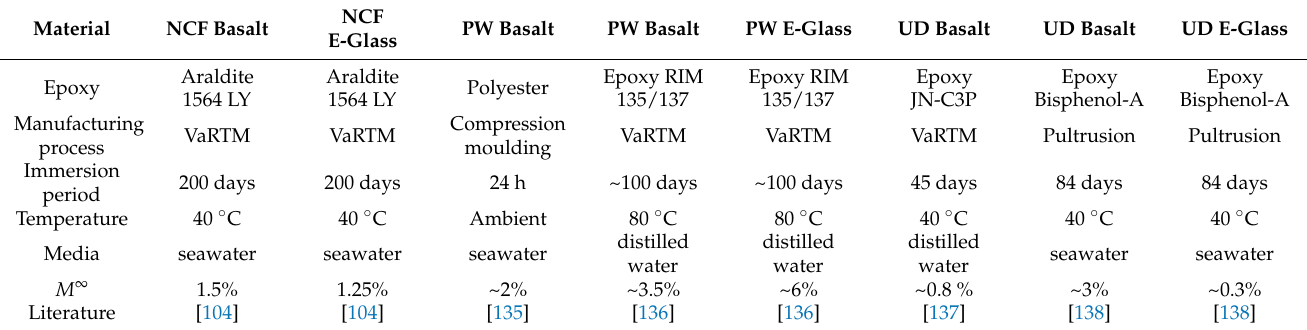
Table 5. An overview of the variation in moisture absorption capacity, M ∞ . data obtained from the lit- erature when different types of reinforcement, epoxy resin, manufacturing technology and condition- ing environment has been used (PW—Plain-woven, NCF—Non-crimp fabric,